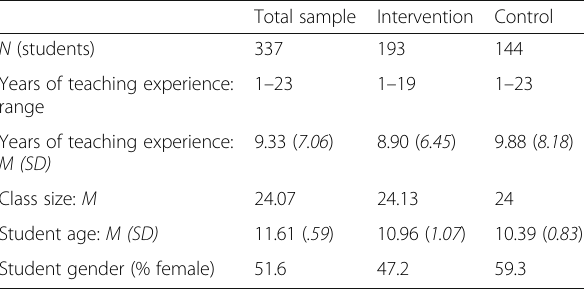
Table 1 Descriptive statistics for teacher, classroom, and student